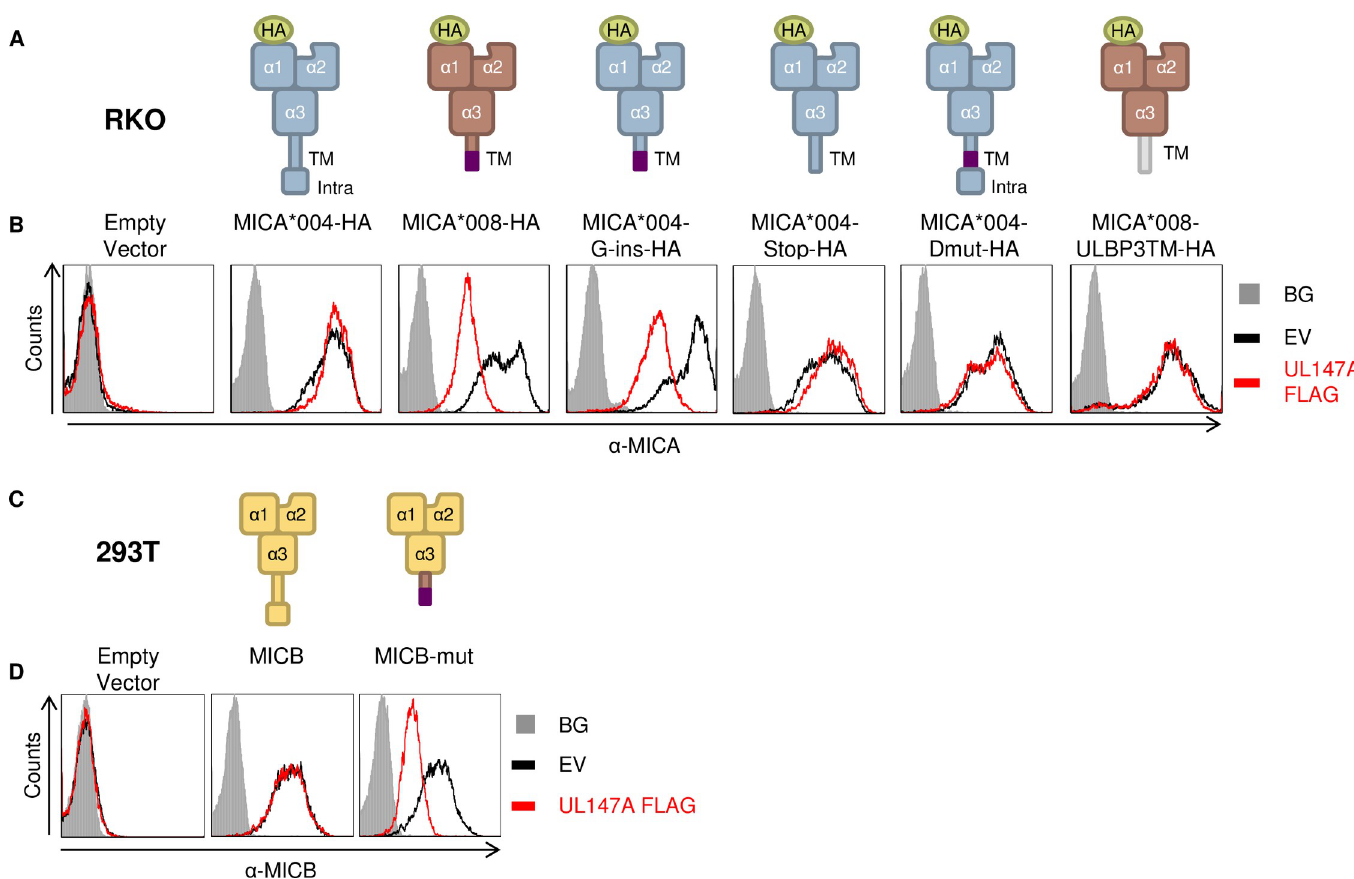
Fig 4. Specific MICA � 008 features are required for UL147A-mediated downregulation. (A) Schematic representation of the MICA mutants and chimeric proteins used to identify which feature of MICA � 008 is recognized by UL147A. Annotated are the N-terminal HA tag, α 1–3 domains, the transmembrane (TM) domain and the intracellular tail (intra). The frameshifted MICA � 008 sequence is shown in purple. (B) FACS staining of MICA expression in RKO cells transduced with the MICA proteins described in (A) and co-transduced with an EV (black histogram) or with UL147A-FLAG (red histogram). Gray-filled histograms represent secondary antibody staining of EV cells, all control stainings were similar to the one shown. Representative of three independent experiments. (C) Schematic representation of MICB and a mutated MICB with MICA � 008’s TM domain. (D) Anti-MICB FACS staining of 293T cells transduced with an EV (left histogram); with WT MICB (middle histogram); or with MICB-mut (right) and co-transduced with an EV (black histogram) or with UL147A-FLAG (red histogram). Gray-filled histograms represent secondary antibody staining of EV cells, all control stainings were similar to the one shown. Representative of three independent experiments.